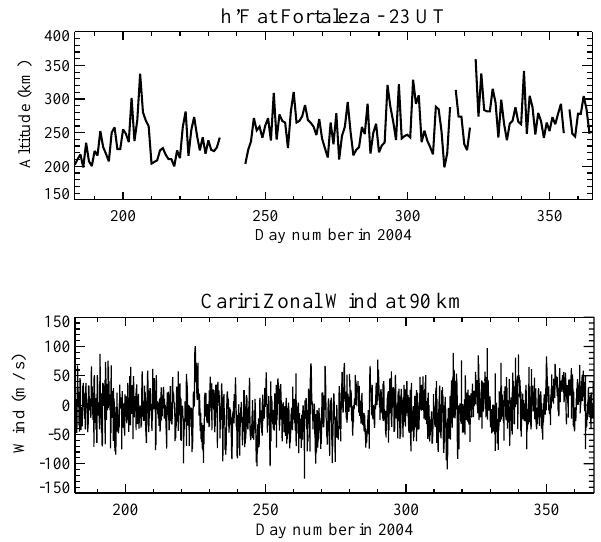
Fig. 2. (Top) Ionospheric F-layer h 0 F time series at 23:00 UT (20:00 LT) observed at Fortaleza, and (Bottom) zonal wind at 90km height observed at Cariri, from 1 July to 31 December 2004.